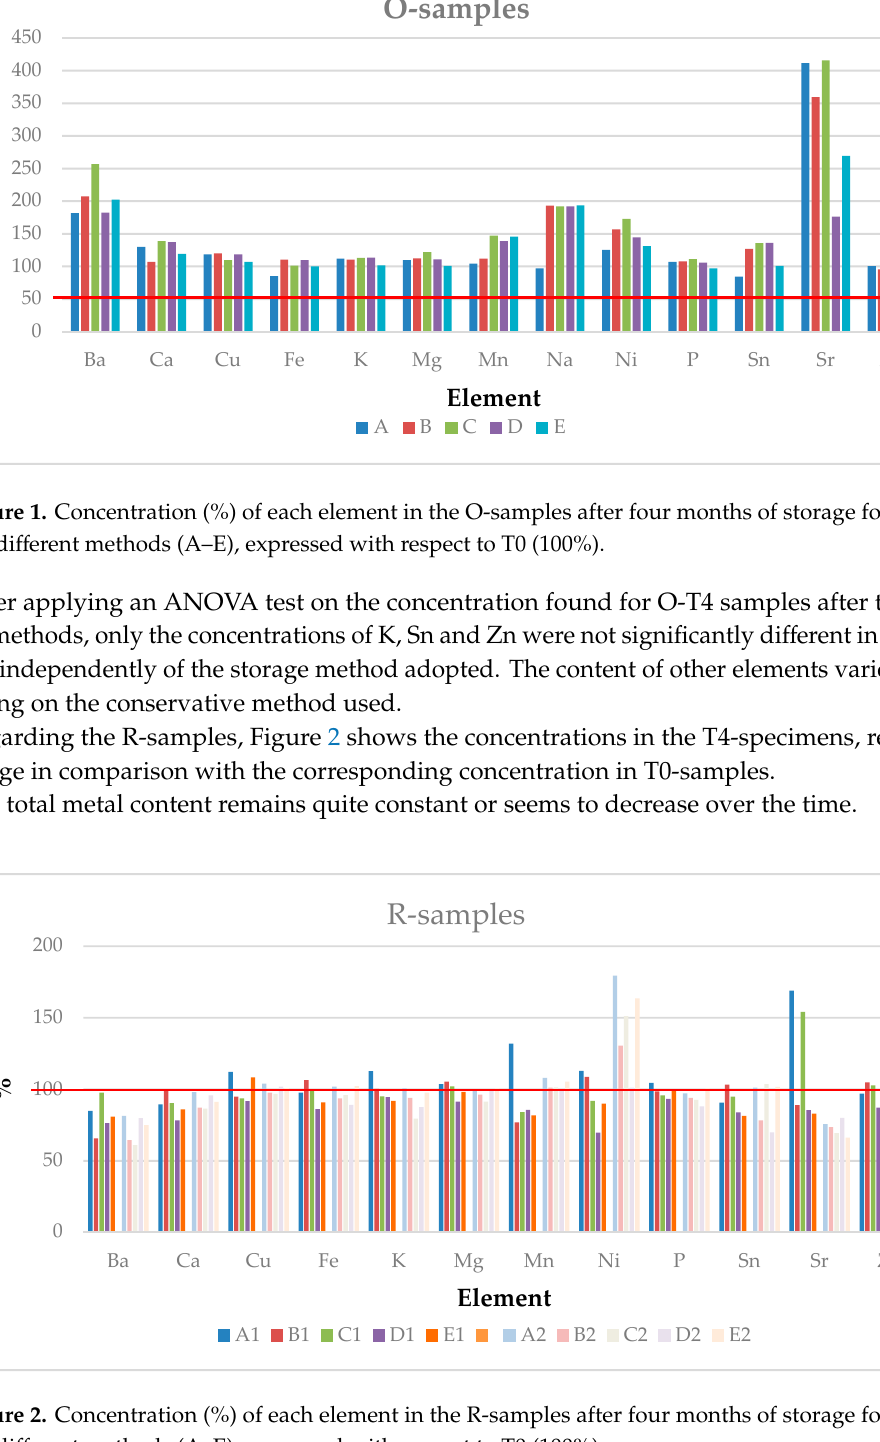
Figure 1. Concentration (%) of each element in the O-samples after four months of storage following the different methods (A–E), expressed with respect to T0 (100%).